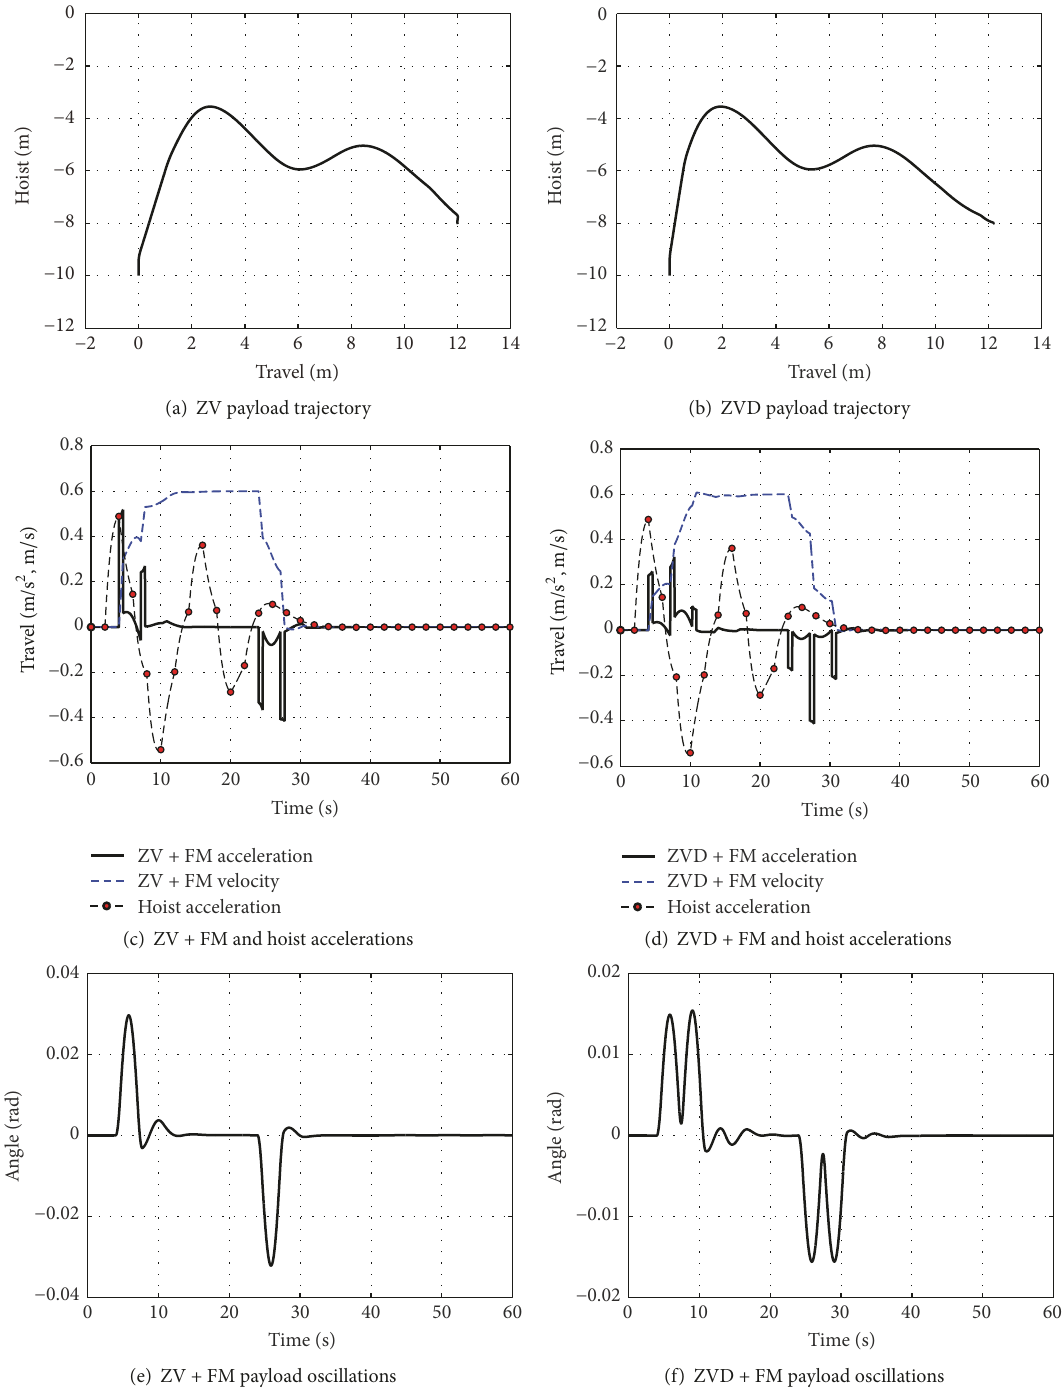
Figure 10: Simultaneous travel and hoisting maneuver using FM shaped